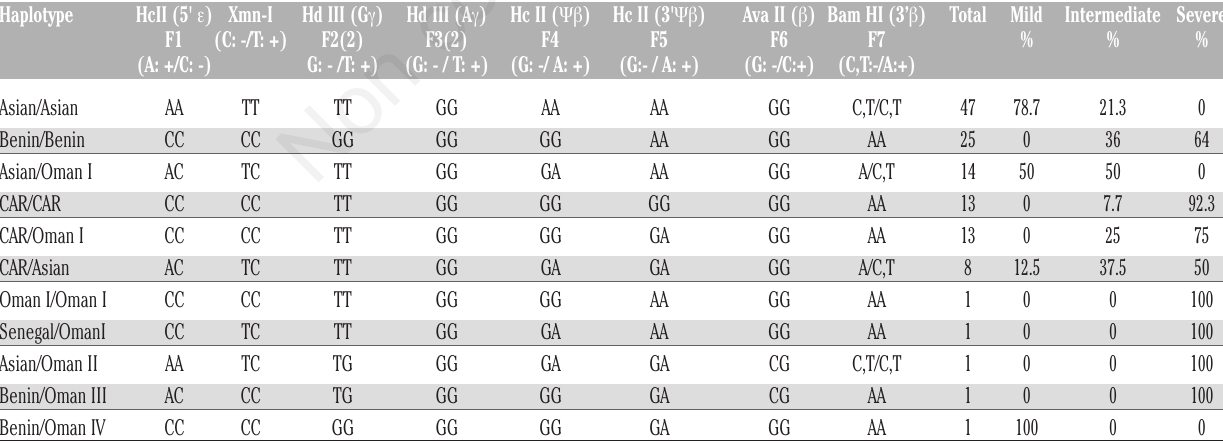
Table 3. Summary of the genotypes from which the 11 haplotypes were determined in the Omani HbS/S homozygous patients using the five 5’ traditional sites. The Xmn-I genotype and percentages of mild, intermediate and severe cases within each haplotype is also indicated.